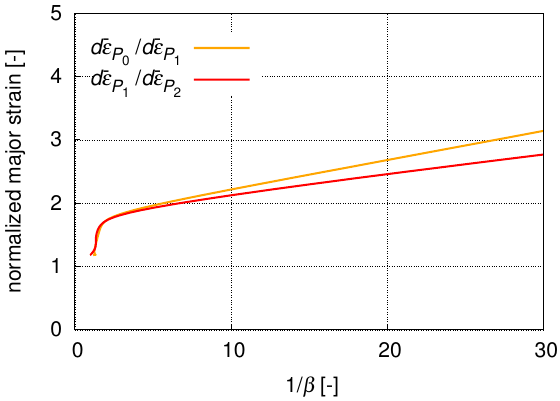
Figure 15. Corresponding major strains (normalized with respect to the mean uniform strain) for different strain increment ratios (1/ β ) for a sample.